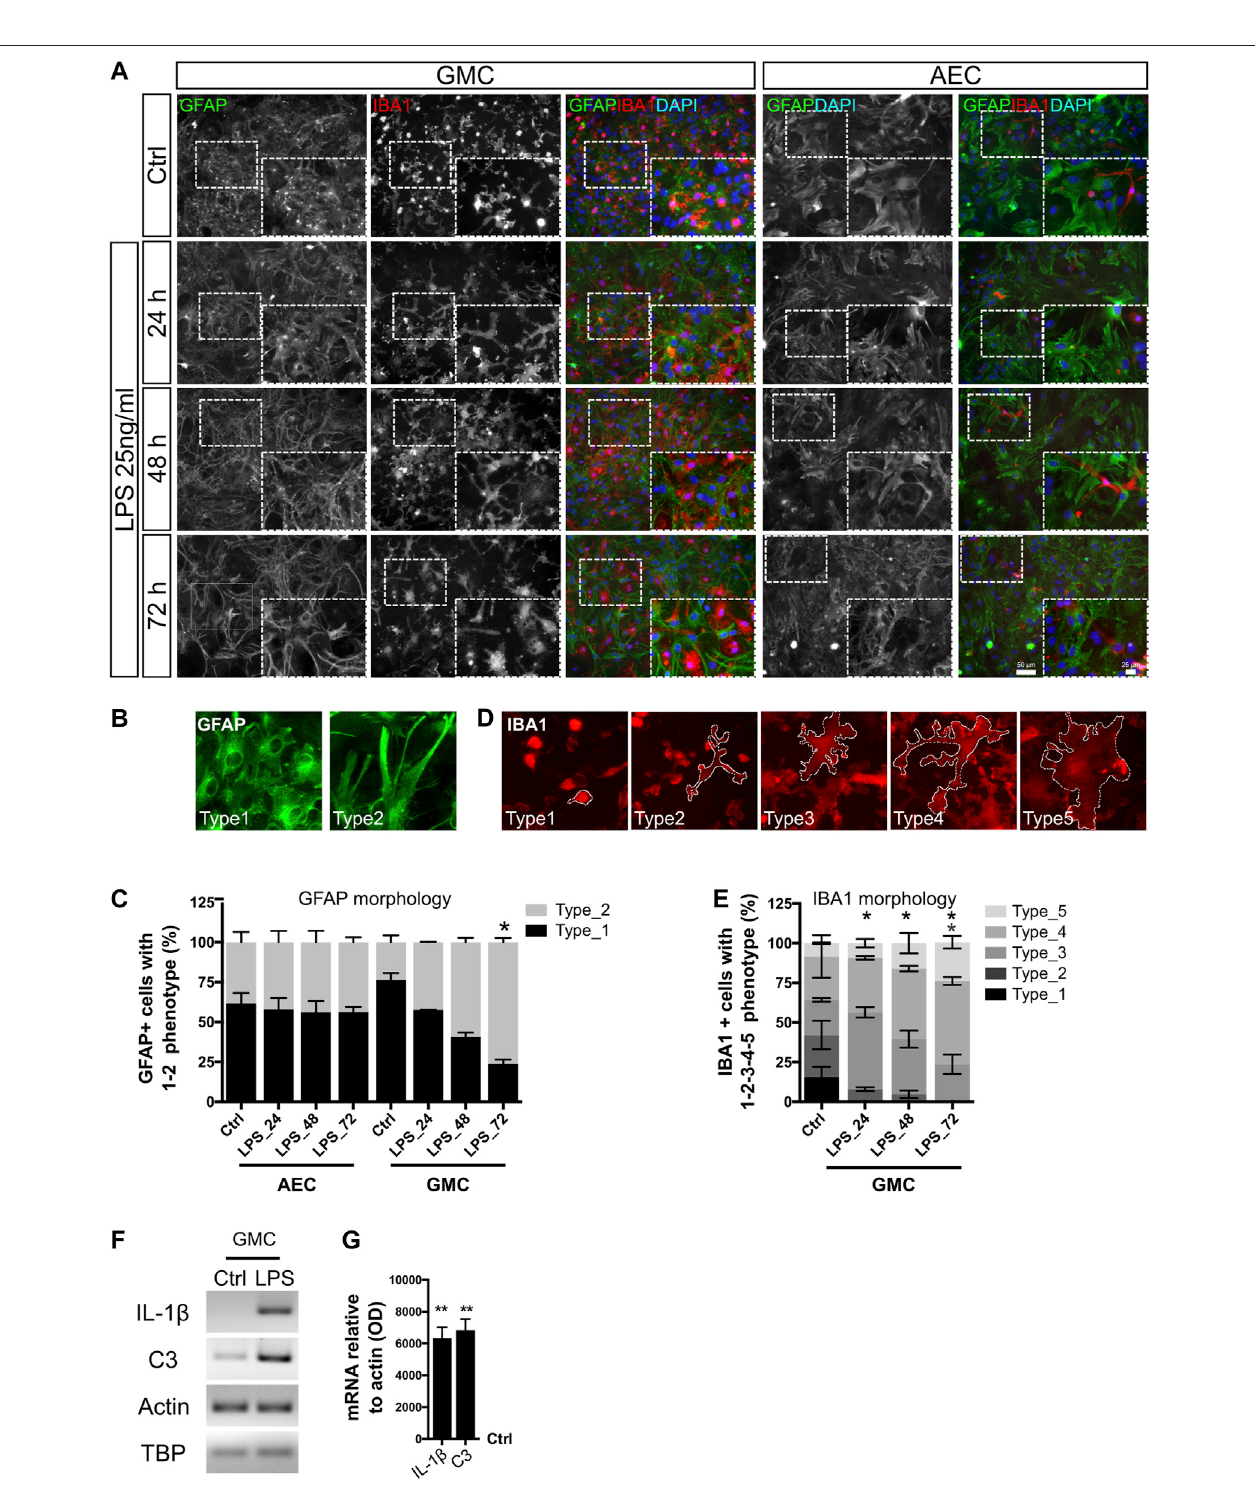
FIGURE 1 | Phenotypic conversion of astrocytes and microglia in response to LPS. (A) Astrocyte-enriched cultures (AECs) and glial mixed cultures (GMCs) were incubated with LPS during the indicated time points in reduced-serum medium. To address cell morphology in response to LPS, we performed double immuno fl uorescence staining for GFAP and Iba-1 to distinguish astrocytes and microglia, respectively. (B) Representative images of the morphological classi fi cation of GFAP + astrocytes in vitro . Type 1 astrocytes are polygonal-shaped astrocytes with few projections and type 2 astrocytes present highly stellated and elongated morphology. (C) Abundance of GFAP + astroglial cell types for AEC or GMC at the analyzed time points. Bars show the mean percentage of three to four biological